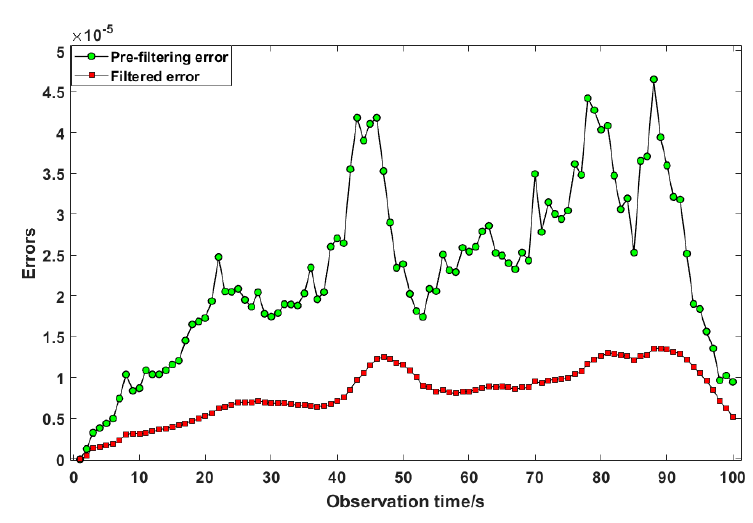
Figure 10. Track of movement.